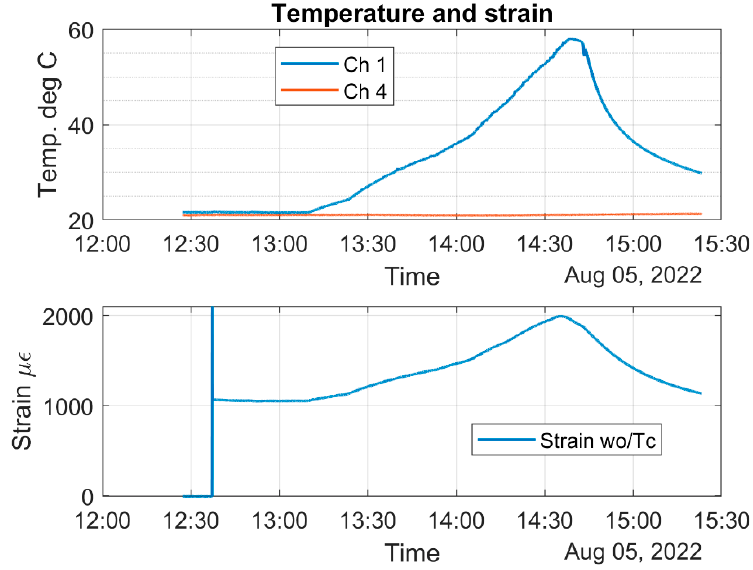
Figure 23. Temperature of the lab and the water solution and sensor’s strain versus time.